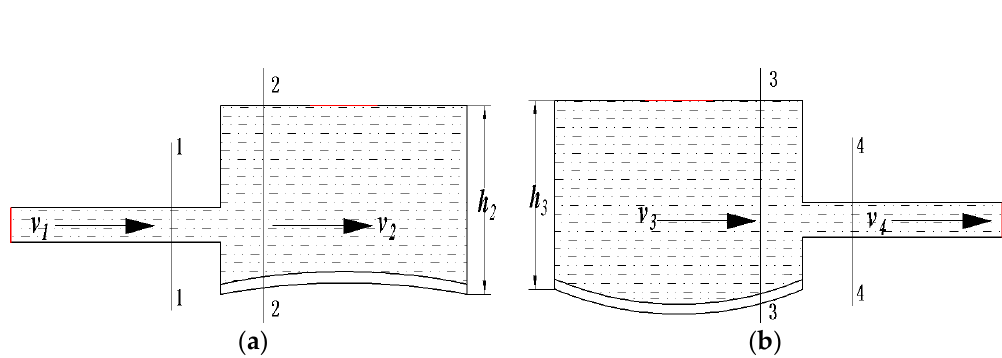
Figure 10. The schematic diagrams of fluid flow in the elastic inlet and outlet cavities. ( a ) Fluid flow in the elastic inlet cavity; ( b ) fluid flow in the elastic outlet cavity.